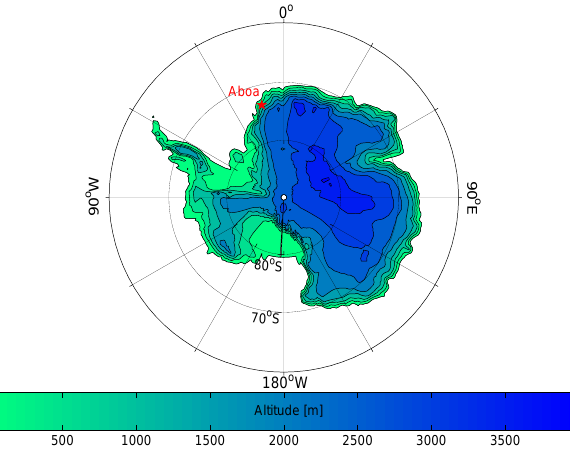
Fig. 1. Map of Antarctica where Aboa station is marked with a red star. The colourmap over the land areas presents the altitude in